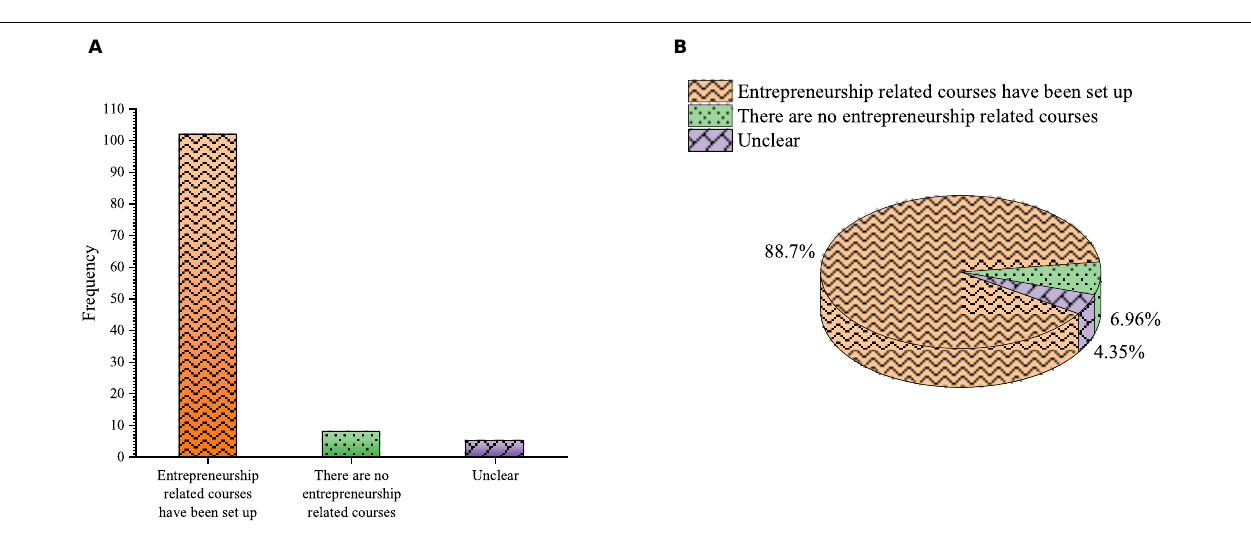
percentage of students who choose external staff is 6.09%,